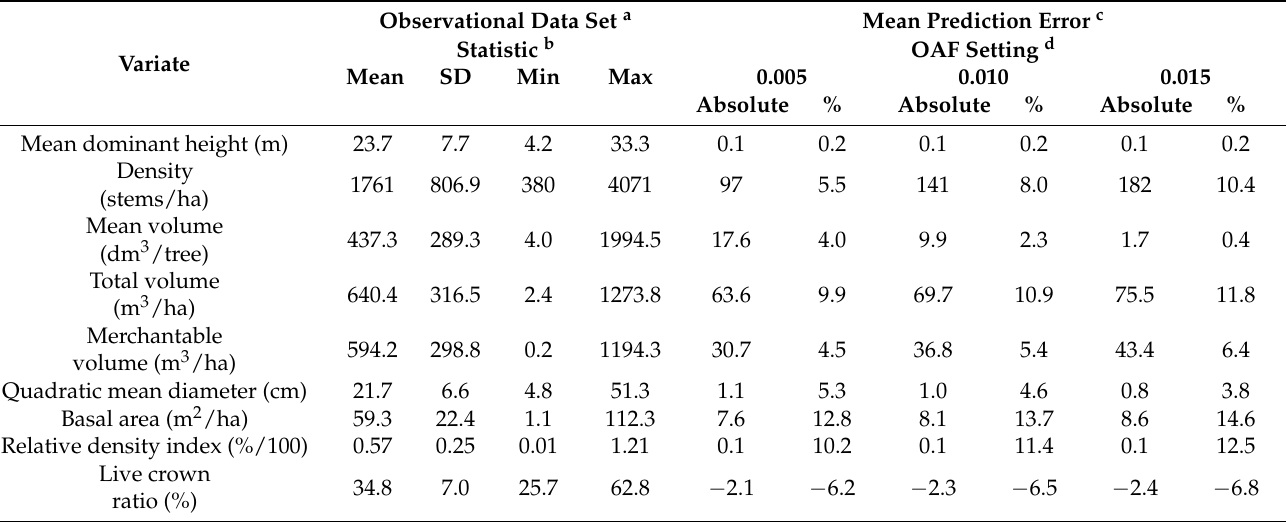
Table A1. Model valuation: test data set characteristics and simulation-derived error prediction